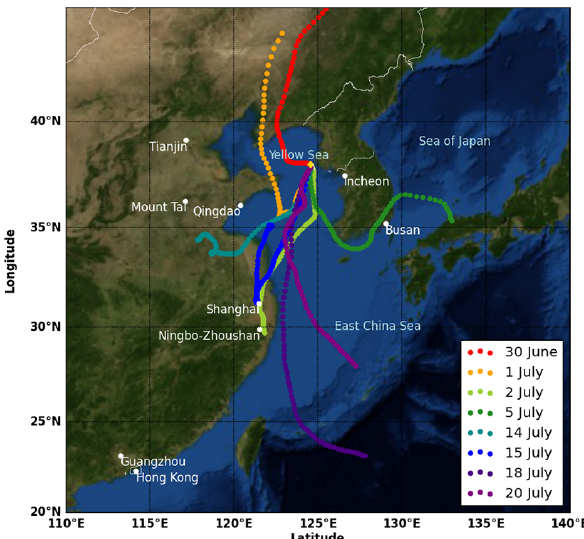
Figure 2. Back trajectories of air masses intercepted during fog events (72h at 1h time resolution; HySPLIT). Locations labeled on plot include Mount Tai, where previous atmospheric water chemi- cal measurements were made, and the highest throughput shipping ports in the region pictured. The BYI ARC is shown as a gold dia- mond. Sectors were defined to determine whether particular source regions existed for chemical constituents of the fog: northerly (30 June and 1 July), westerly (2, 14, and 15 July), southerly (18 and 20 July), and easterly (5 July). Each trajectory was initiated at the approximate beginning of a fog event. Imagery from NASA Blue Marble; plot generated using Python Matplotlib Toolkit BaseMap.